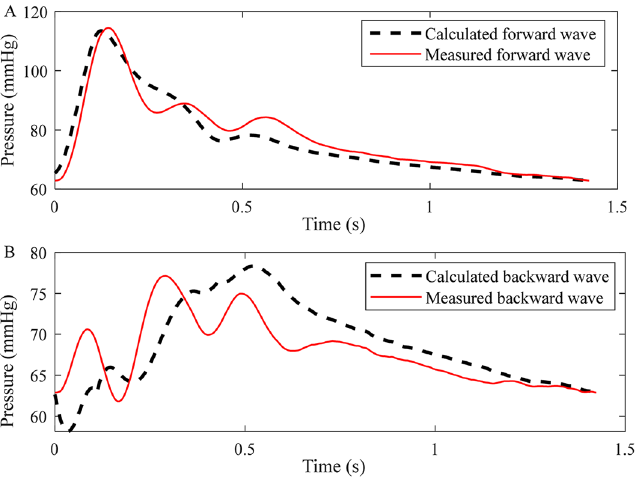
Figure 6. The measured and calculated waves of a representative subject. ( A ) Forward waves; ( B ) backward waves.